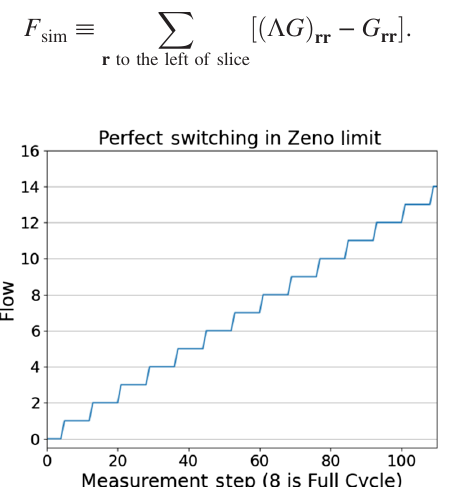
FIG. 5. Charge transfer of the left half filled plane in the Zeno limit with ð T= 8 Þ ¼ ð π = 2 Þ ; namely, p ¼ 1 . In this section, the Lieb lattice size for all simulations is 33 × 33 unless otherwise stated. Here, precisely one particle is transported across the flow cut during the eight-step measurement